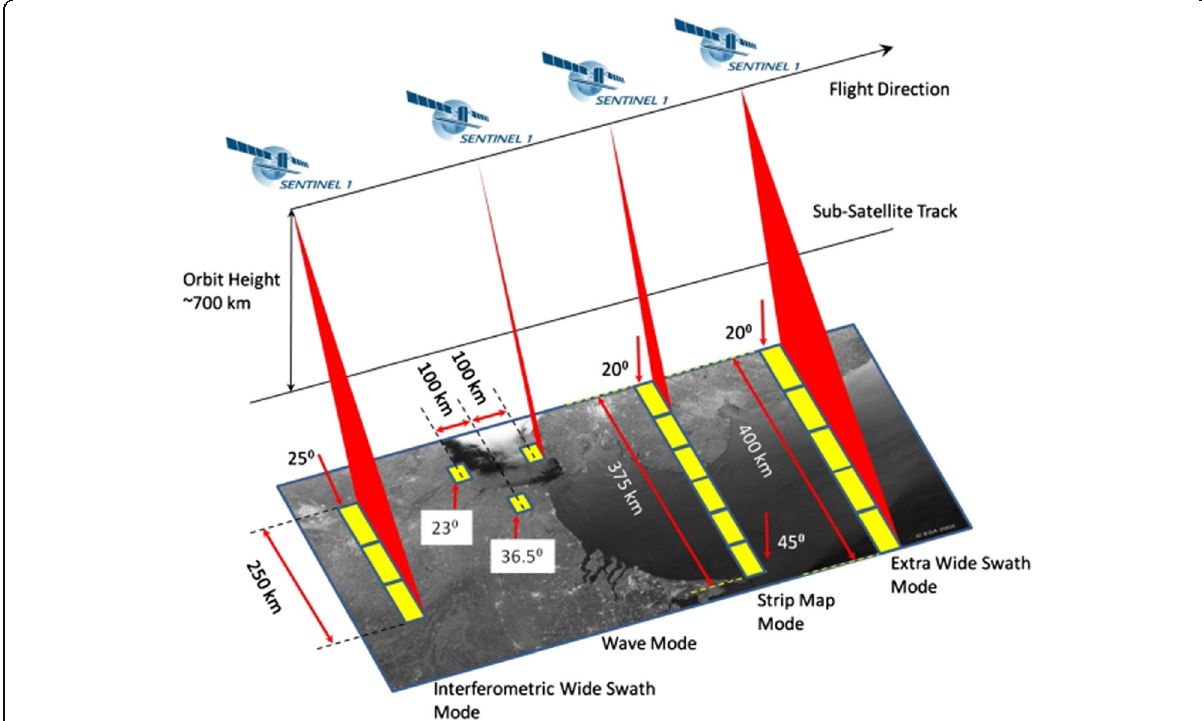
Fig. 8 Four acquisition modes for Sentinel-1 (from https://sentinel.esa.int/web/sentinel/technical-guides/sentinel-1-sar/sar-instrument under the subheading Acquisition Modes). Radar satellites differ from optical sensors by their ability to shift between different acquisition modes to accomodate a larger suite of